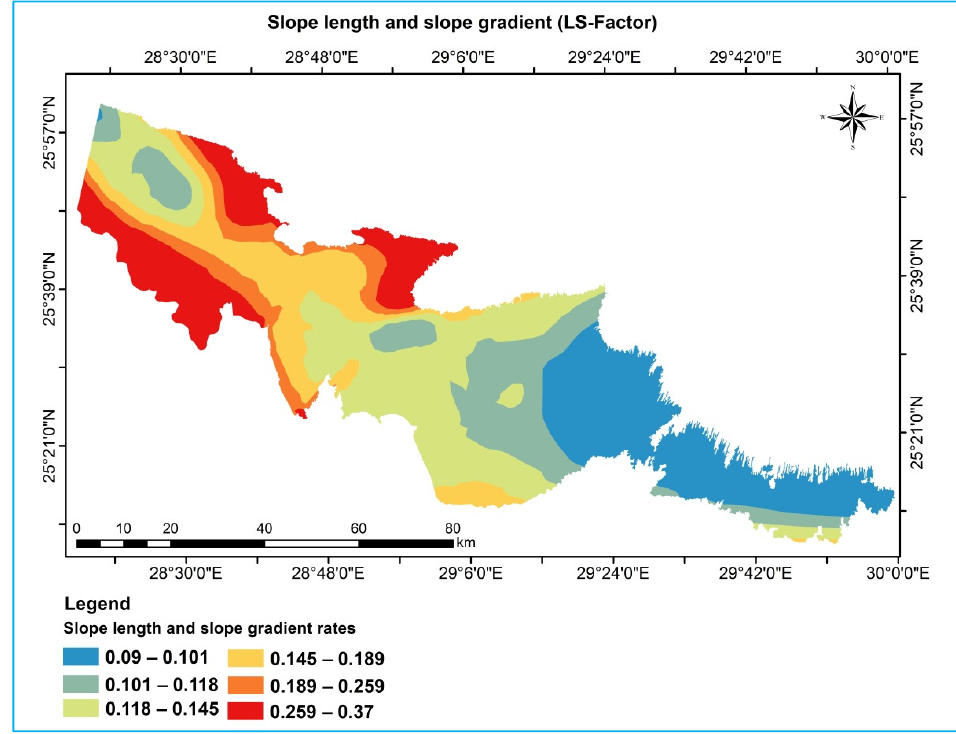
Figure 8. Spatial distribution map of slope length and slope gradient factors (LS-Factor).